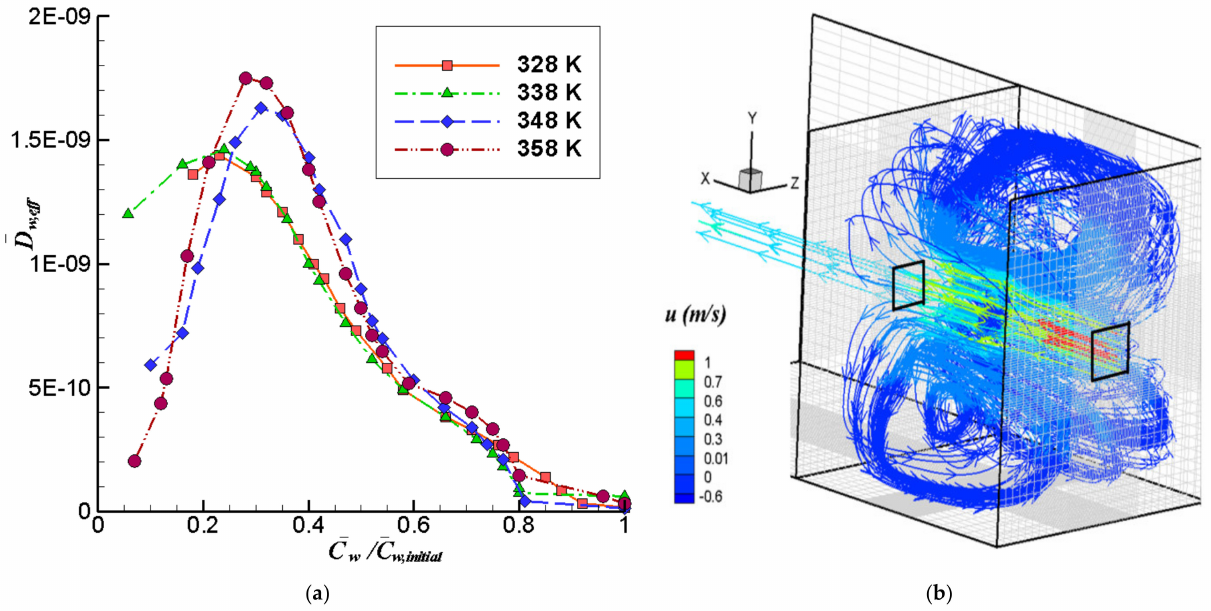
Figure 5. ( a ) Mean effective moisture diffusion coefficient variation as a function of dimensionless average moisture concentration. ( b ) 3D mean streamlines and u velocities (m/s) for the air flow simulation in the